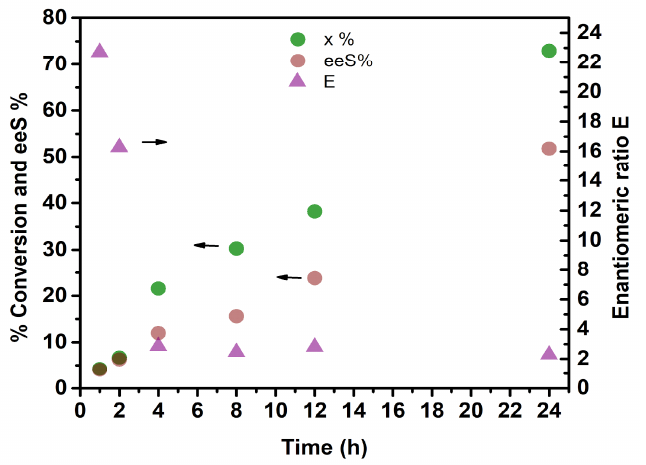
Figure 6. Percentage of conversion (X%), enantiomeric excess (eeS%) toward S -ibuprofen and enantiomeric ratio E (E) versus reaction time in the esterification of rac -ibuprofen with ethanol at 45 °C with isooctane as co-solvent.